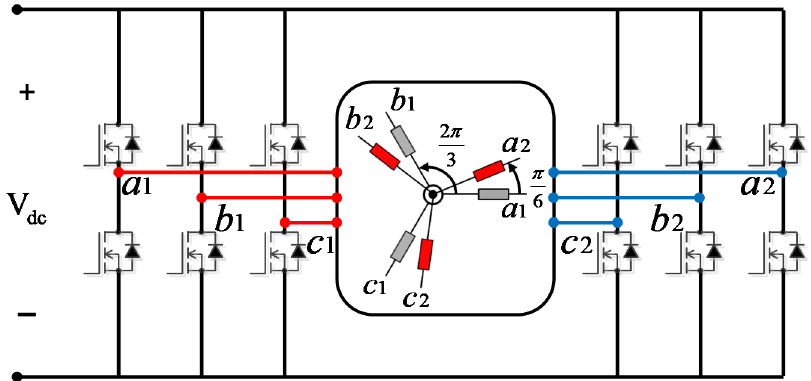
Figure 1. ADTP-SM drive system model [3,5].